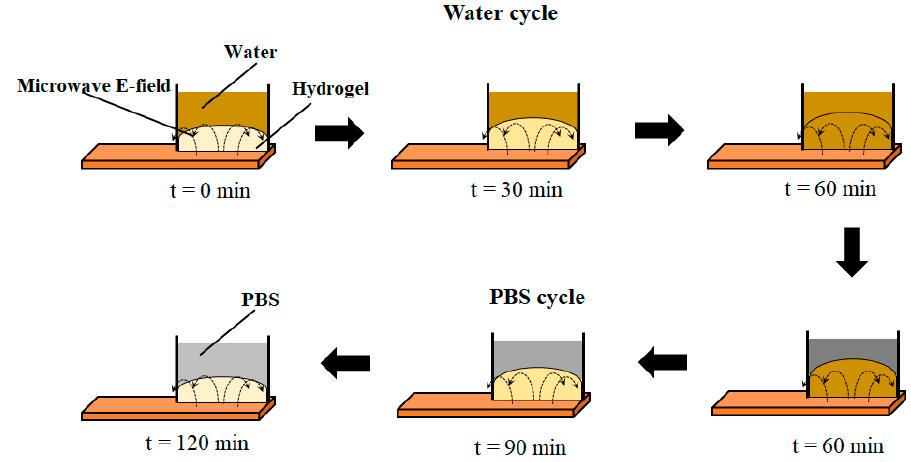
Figure 15. Schematic illustrating the behavior of a hydrogel as an encapsulation medium for water.